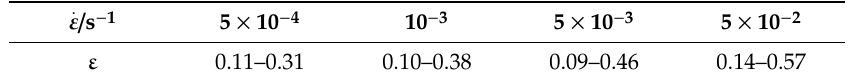
Table 1. Strain range of softening mechanism of Ti–6Al–4V at 860 °C and different strain rates.